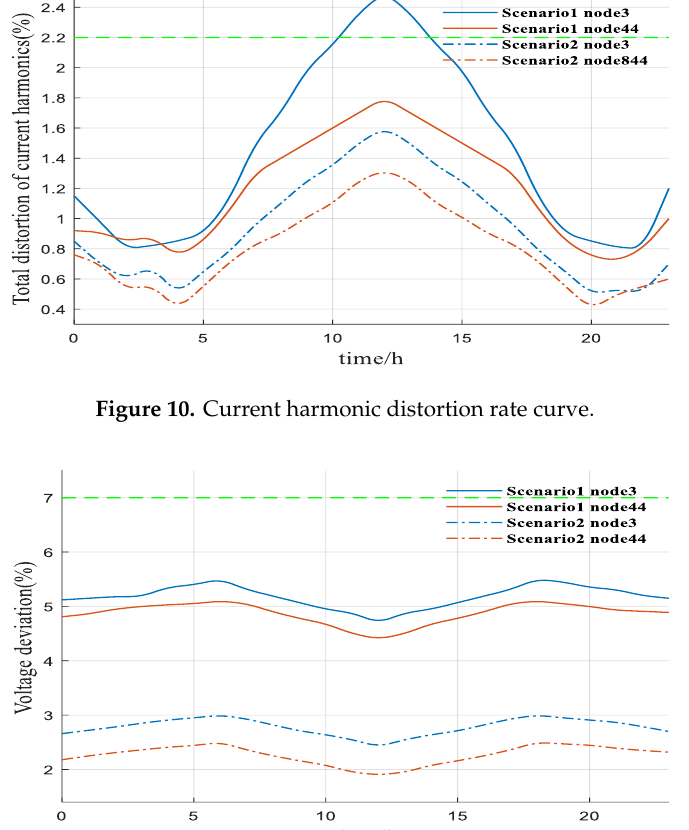
Figure 12. Voltage fluctuation curve.